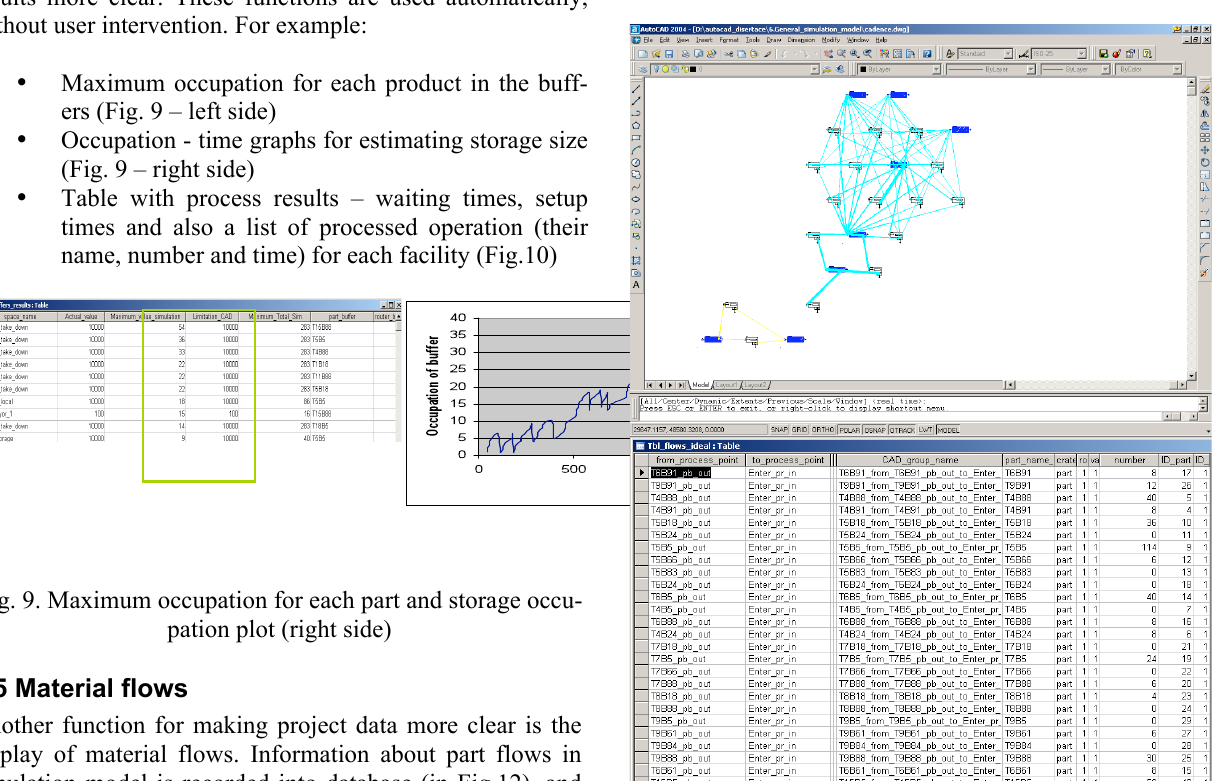
Fig.10. Detailed processes statistics